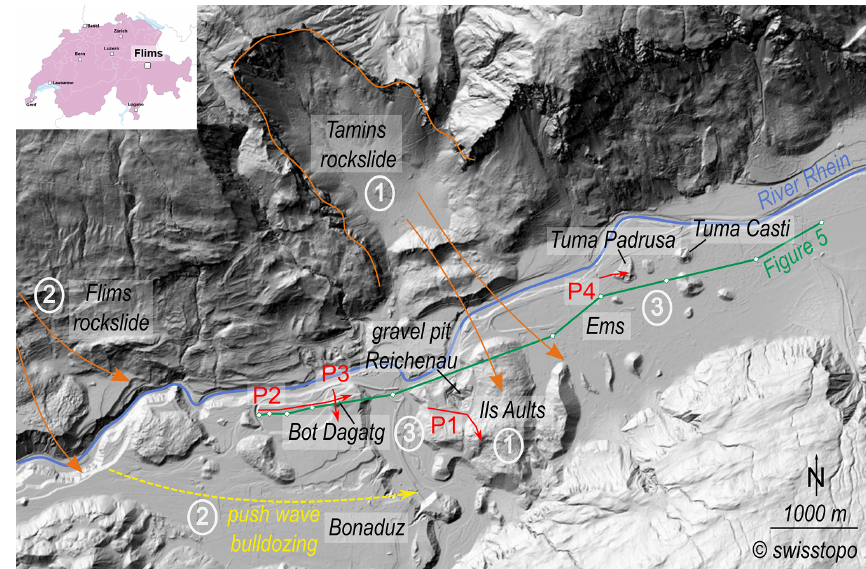
Figure 1. Overview of the study area in the Rhein River valleys depicting the scarp of the Tamins rockslide, the Ils Aults consisting of Tamins deposits, and parts of the impact zone of the Flims rockslide and toma hills (e.g. Bot Dagatg, Tuma Padrusa, and Tuma Casti). The ERT profiles P1–P4 (Fig. 4) are marked with red colour. The green profile links drilling sites (white markers) and is shown in Fig. 5. The circled numbers correspond to the evolution phases. High-resolution digital elevation model (DEM): ©